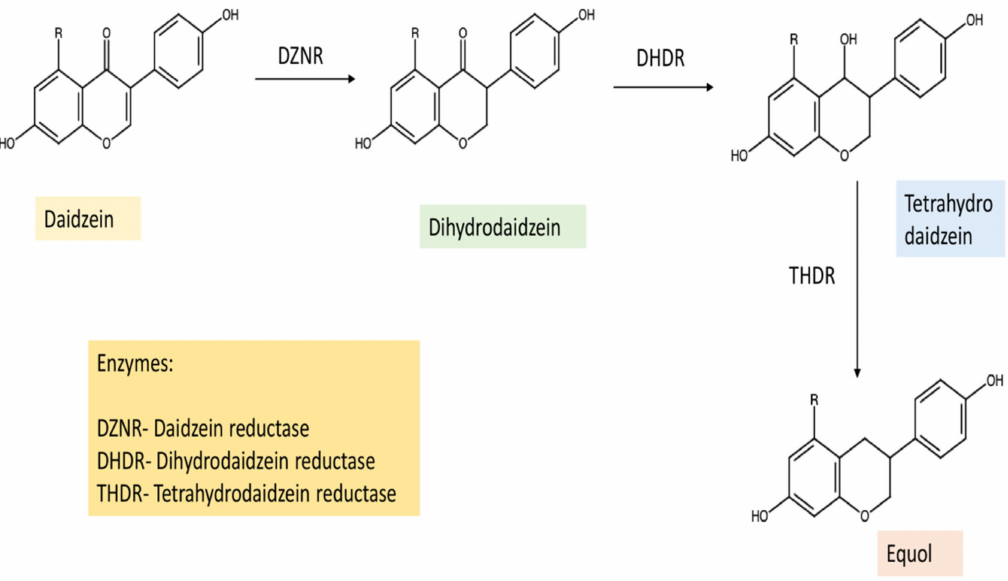
Figure 1. Diagrammatic representation of equol biosynthesis with the enzymes